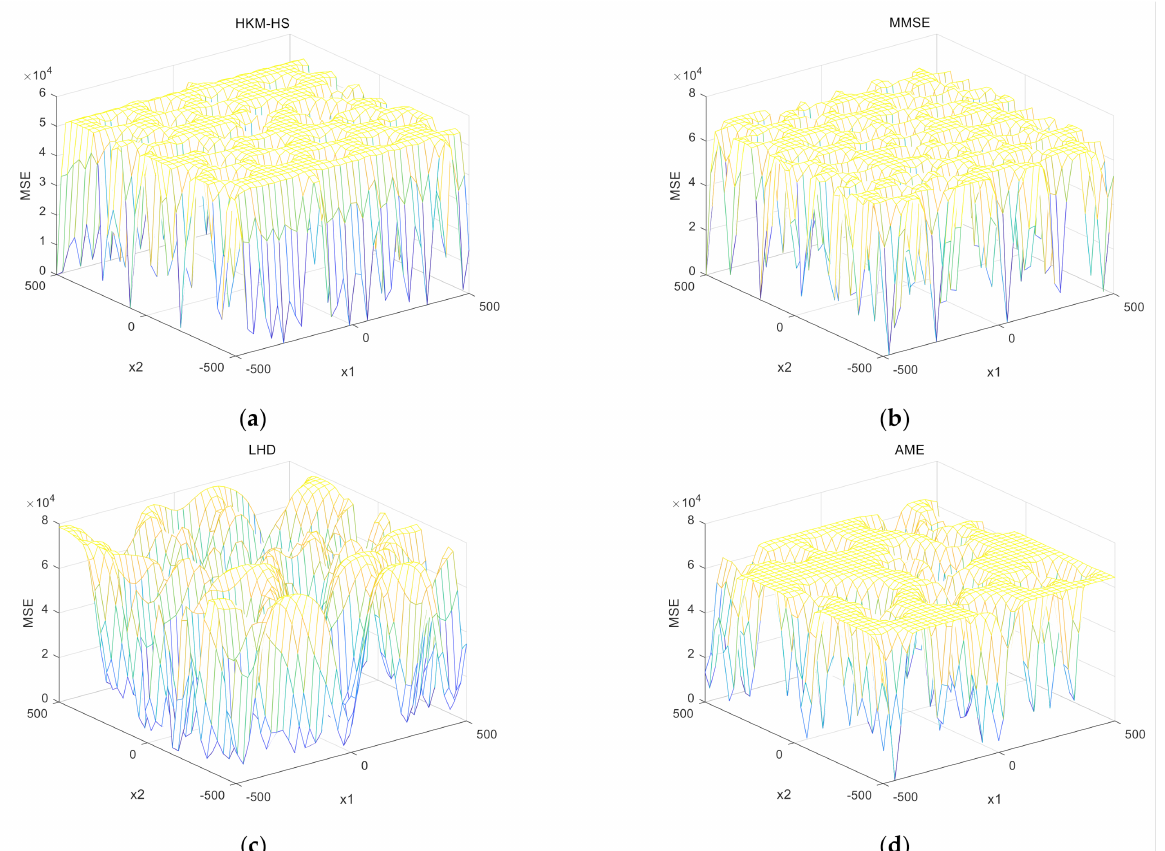
Figure 5. ( a )Test result of Schwefel function by HKM-HS; ( b ) Test result of Schwefel function by maximum mean square error (MMSE); ( c ) Test result of Schwefel function by Latin Hypercube Design (LHD); ( d ) Test result of Schwefel function by adaptive maximum entropy